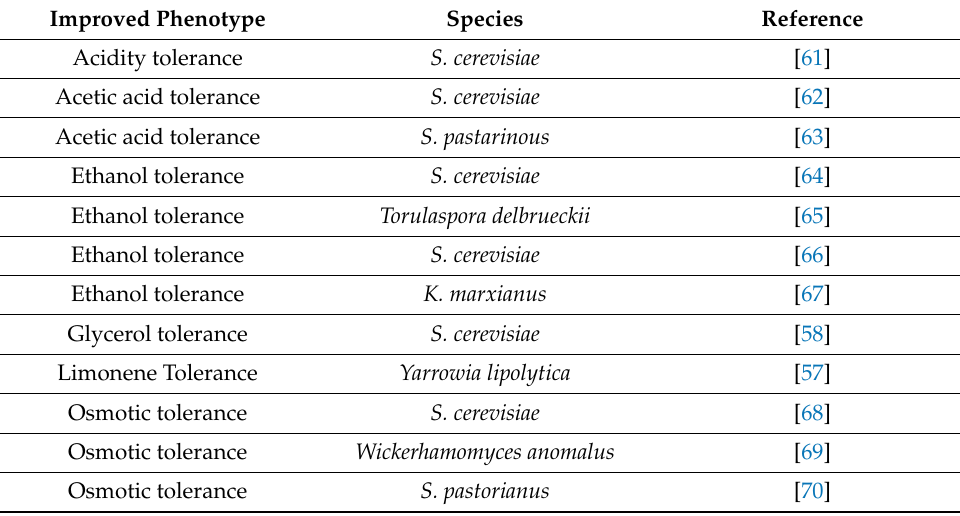
Table 1. Phenotypes improved by adaptive laboratory